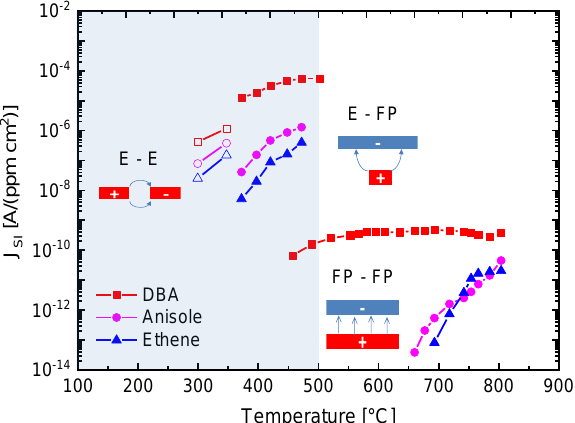
Figure 11. Temperature dependence of the surface ionization current density in dependence on analyte gas species and emitter and collector electrode arrangements (FP-FP: Flat-plate to flat-plate; E-FP: Edge to flat-plate; E-E: Edge to edge). All data in this figure were obtained with platinum emitter films. Heated emitter electrodes are marked in red with a positive sign on and cold collector electrodes in blue with a negative sign on. In E-E-type devices, both emitter and collector electrodes sit on a common heated substrate. The blue shading indicates the temperature range in which conventional MOX gas sensors are operated.